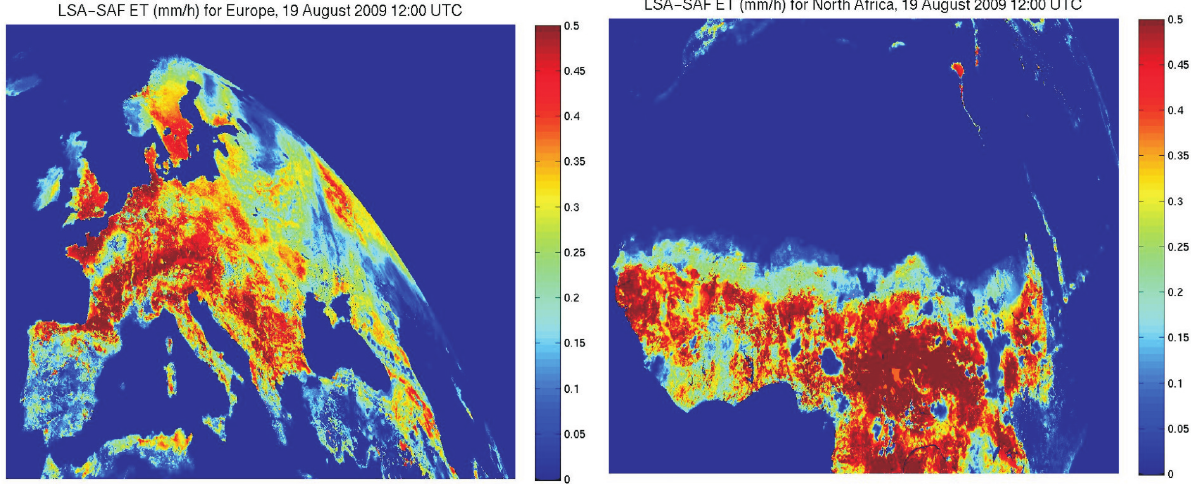
Fig. 1. LSA-SAF ET (mm/h) over Europe (left) and North Africa (right) on 19 August 2009 at 12:00 UTC.